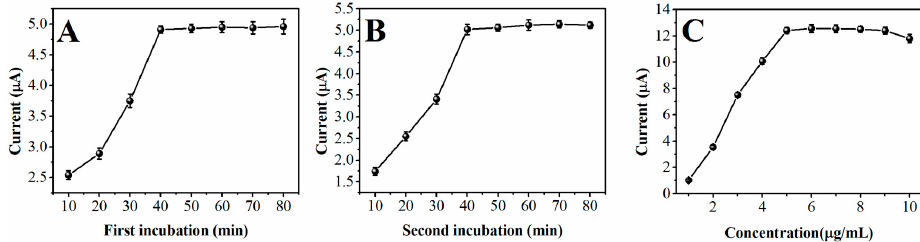
Figure 3. Effect of peak current on the incubation time of ( A ) the first incubation step and ( B ) the second incubation step with 100 ng/mL NSE; ( C ) incubation concentration of anti-NSE, when